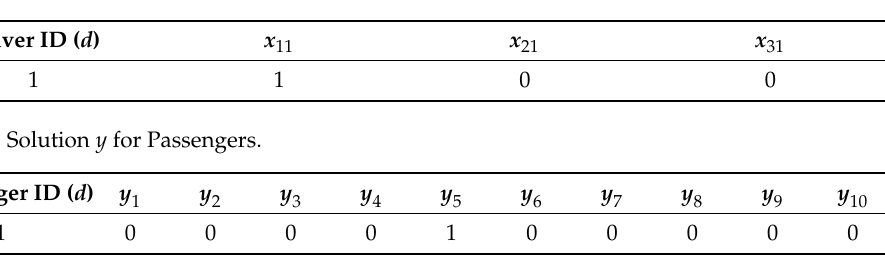
Table 15. Solution x for Drivers.